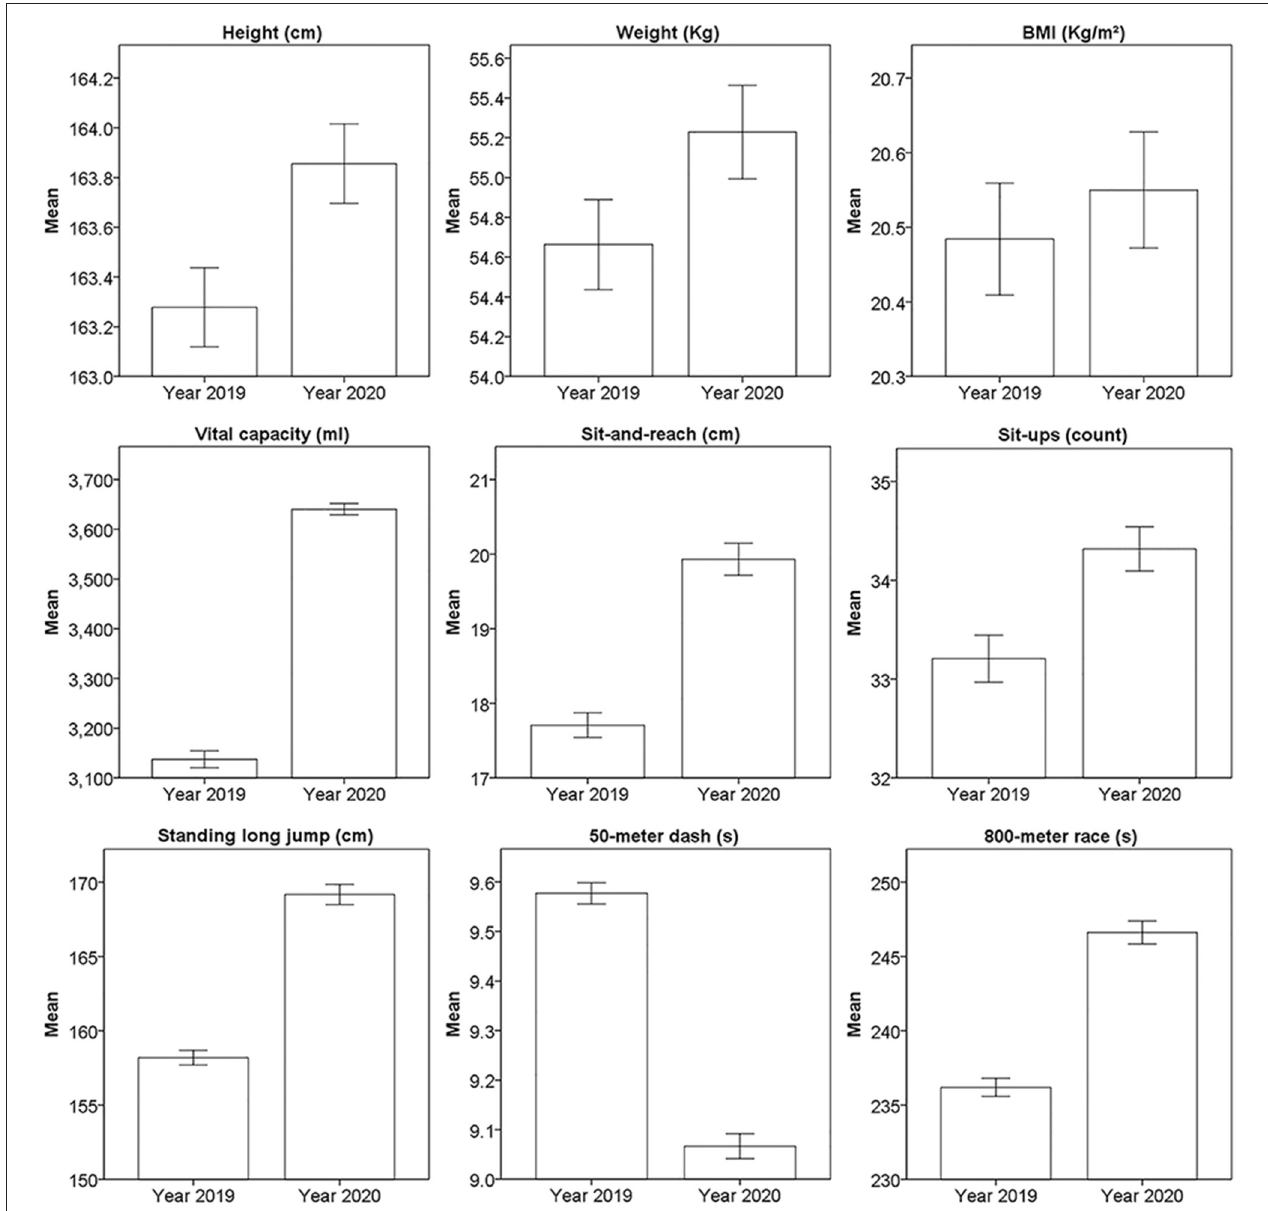
FIGURE 5 | The mean and 95% confidence interval of physical fitness tests from 4,651 female